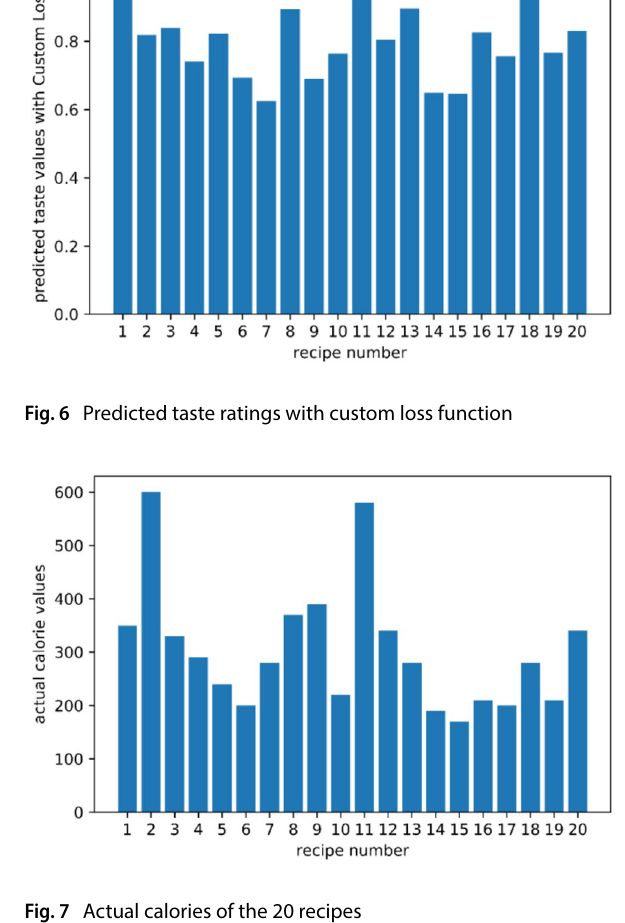
Fig. 7 Actual calories of the 20 recipes